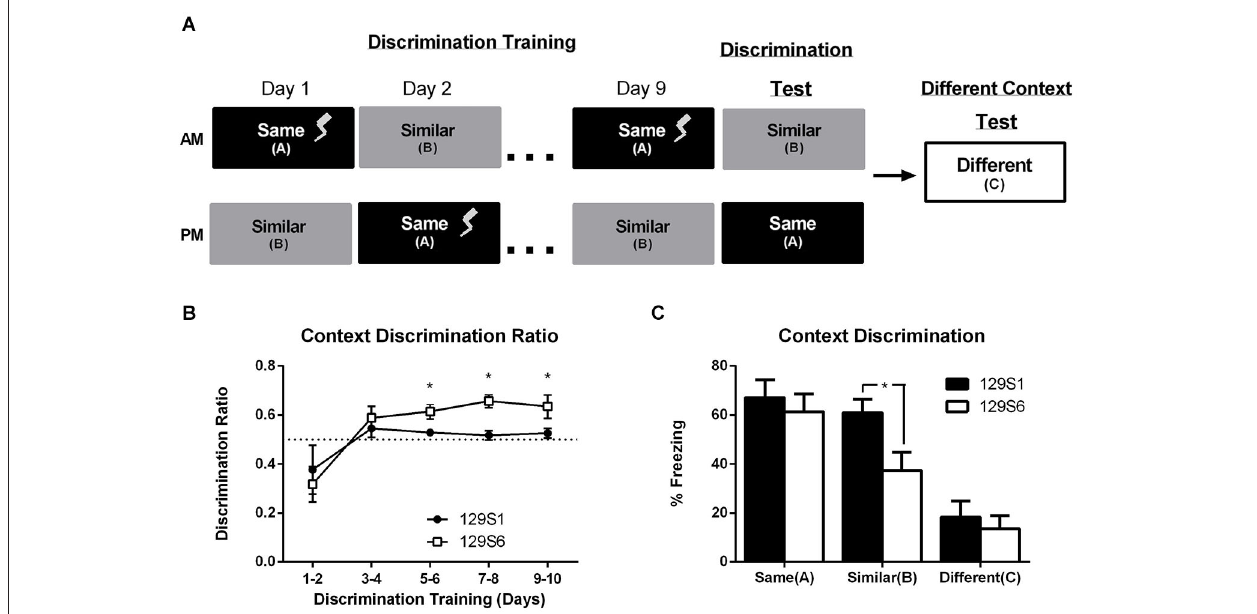
days to counterbalance for order of context exposure. During context discrimination training, 129S6 mice show significant context discrimination on day 5–10, while 129S1 mice failed to exhibit significant context discrimination. * p < 0.05 compared to chance (0.5 ratio; dotted line). (C) On day 10, exposure to context A produced similar levels of freezing in both 129S6 and 129S1 substrains. However, in context B, 129S1 mice exhibited significantly more freezing compared to 129S6 mice. Conversely, both substrains exhibited similarly low levels of freezing when exposed to a novel context (context C). Data are presented as mean ± SEM; * p < 0.05 n = 16 for 129S1 and